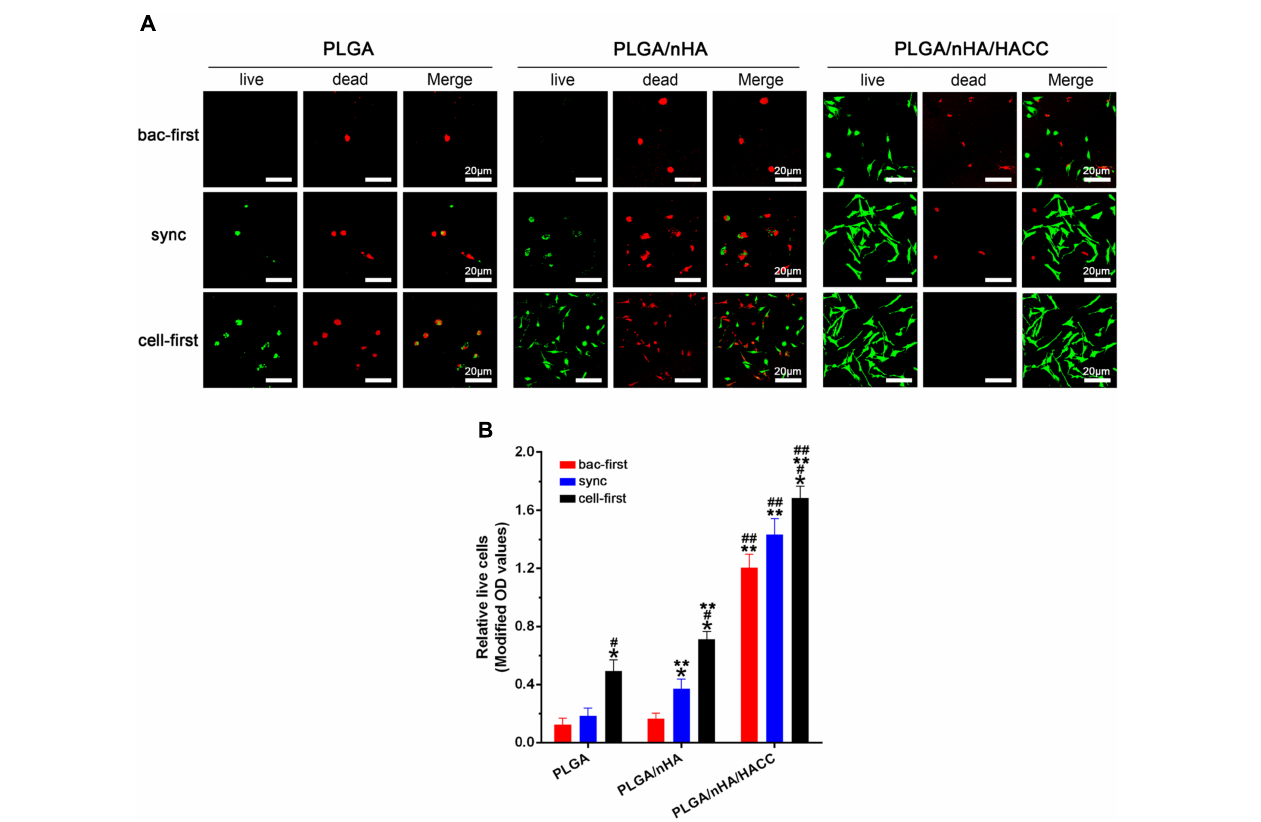
FIGURE 4 | Qualitative and quantitative analyses of MC3T3-E1 cells on different materials surfaces in different co-cultured systems. (A) Qualitative analysis of cell viability on surfaces by the Live/Dead staining assay. Representative images of live cells (green fluorescence) and dead cells (red fluorescence). (B) Quantitative analysis of cell viability on surfaces by CCK-8 assay. ∗ p < 0.05 compared with bac-first group on the same surface. # p < 0.05 compared with sync group on the same surface. ∗∗ p < 0.05 compared with PLGA group in the same co-cultured system. ## p < 0.05 compared with PLGA/nHA group in the same co-cultured